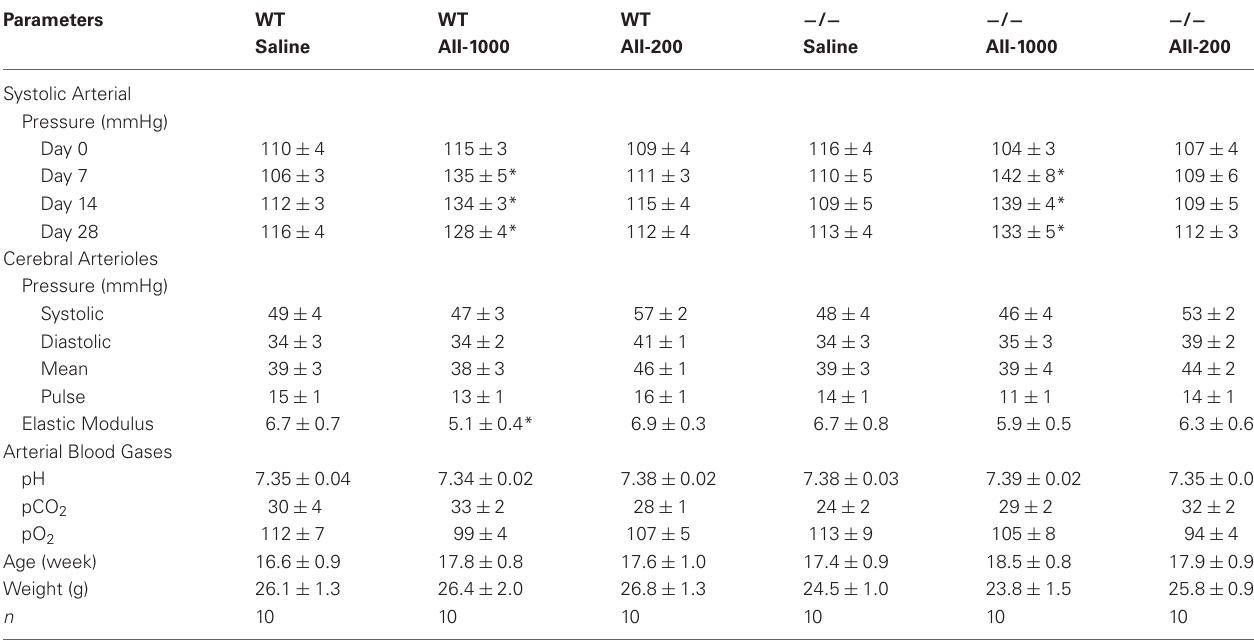
Table 1 | Physiological